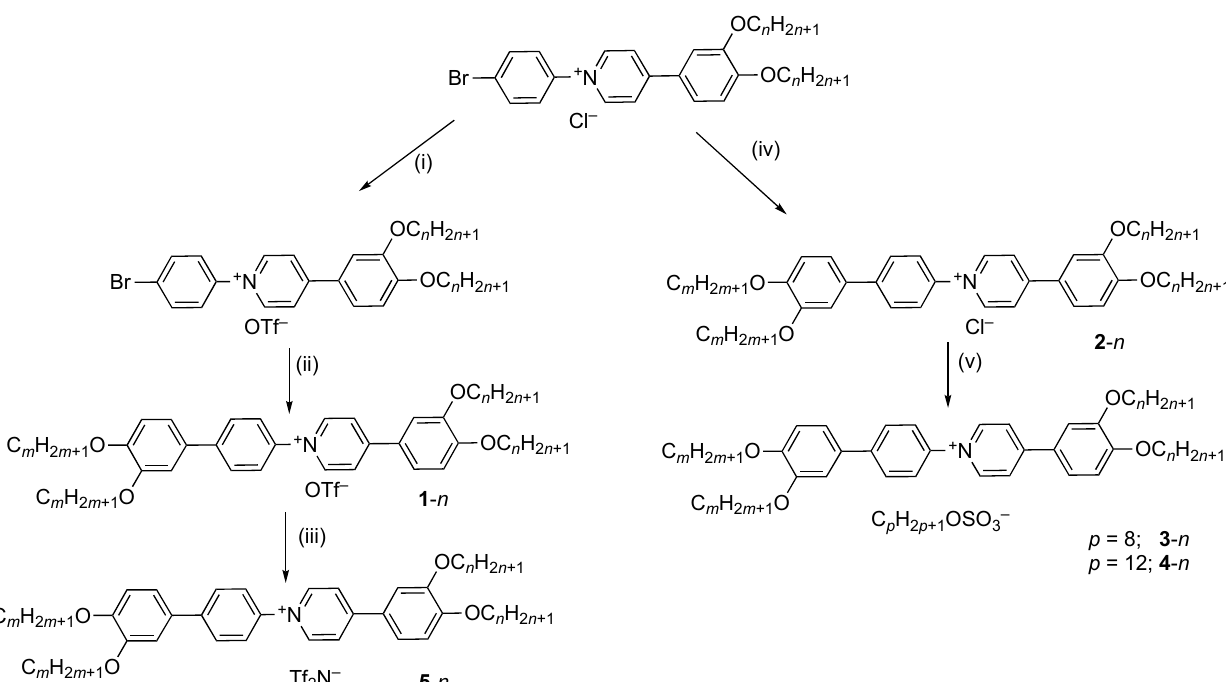
Figure 1. Preparation of the target salts; in all cases n = m . ( i ) AgOTf, DMF, 70 °C ; ( ii ) 3,4-dialkoxybenzene boronic acid pinacol ester, THF/H 2 O (1:1), Na 2 CO 3 , N 2 , [Pd 3 (OAc) 6 ], SPhos, 65 °C; ( iii ) LiTf 2 N / MeOH / Δ ; ( iv ) 3,4-dialkoxybenzene boronic acid pinacol ester, THF / H 2 O / EtOH (3:3:1), Na 2 CO 3 , [Pd 3 (OAc) 6 ], SPhos, N 2 , 65 °C; ( v ) NaO 3 SOC p H 2 p +1 / MeOH / Δ ( p = 8 or 12).